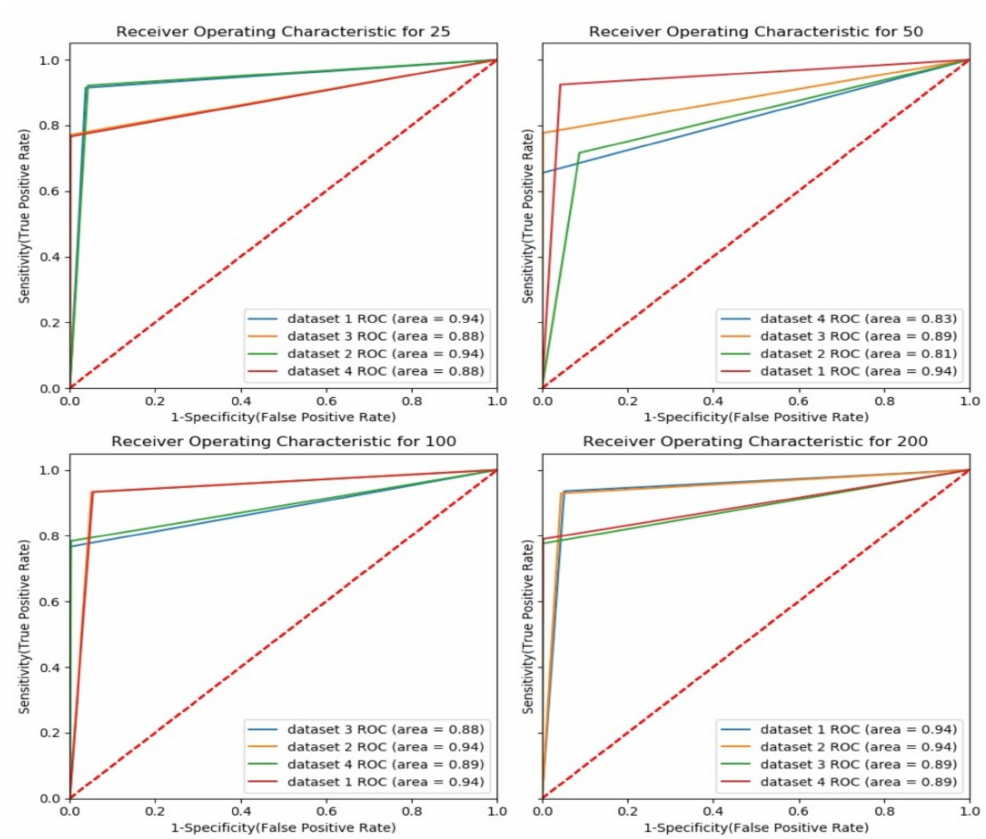
Figure 11. ROC curve for CNN features with SVM model results for each dataset as a second component in our ensemble